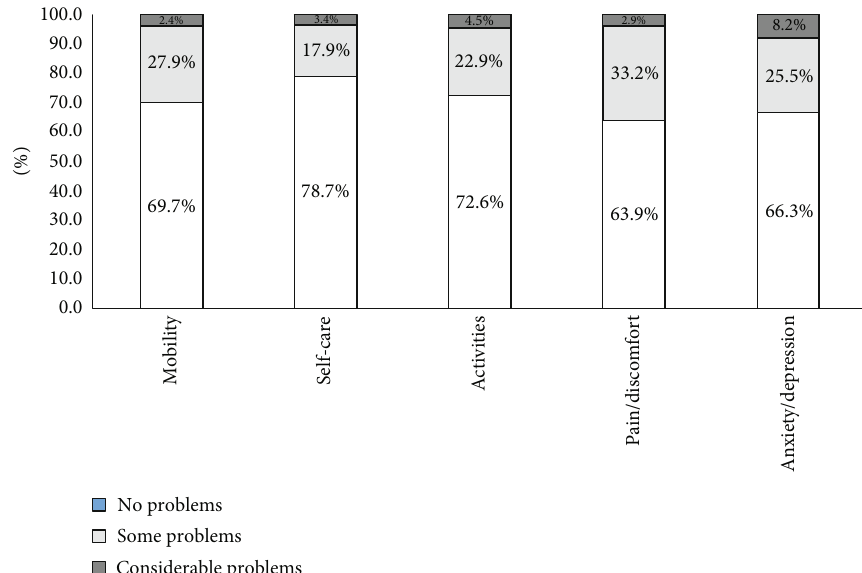
Figure 2: Classi fi cation of patient ’ s response to the EQ-5D modalities. Notes: light segments, no problems; gray segments, some problems; black segments, considerable problems.